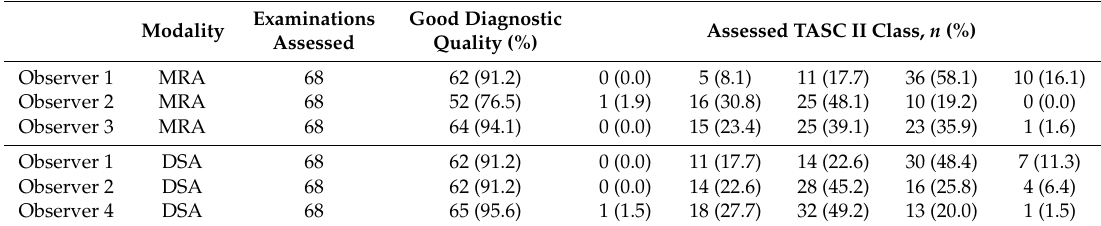
Table 1. Distribution of TASC II classes according to modality and identity of observer. TASC II = TransAtlantic Inter-Society Consensus for the Management of Peripheral Arterial Disease II; MRA = magnetic resonance angiography; DSA = digital subtraction angiography.